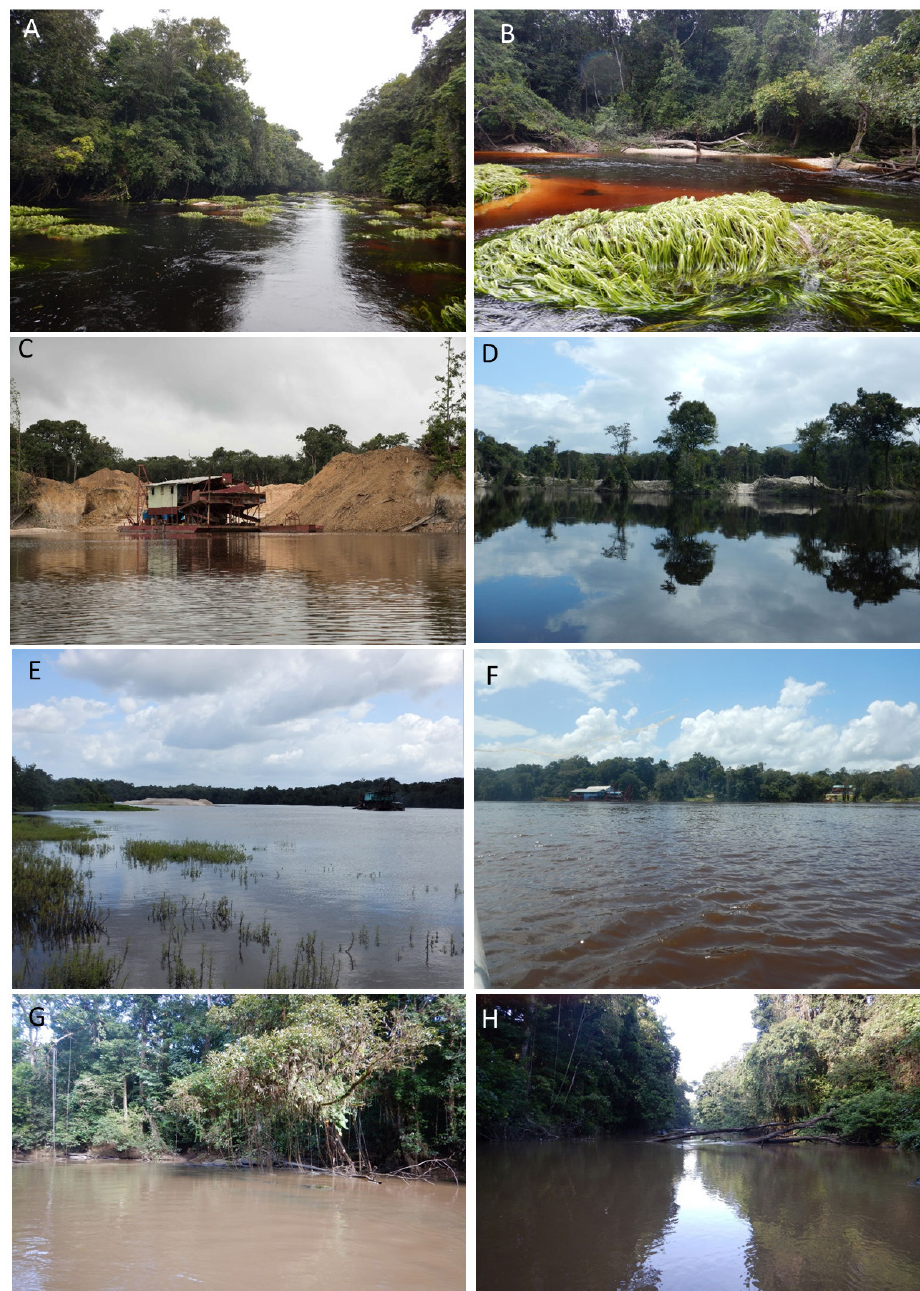
FIGURE 3 | Sampling locations on the middle Mazaruni River: A. Main channel of the upper Eping River a small, black water tributary of the Mazaruni River. This river appeared more pristine and less impacted by gold mining activities; B. Sandy, shallow habitat sampled in middle channel of the upper Eping River; C. A gold dredge in the middle of the Kurupung River, on the right side is evidence of soil removal that resulted from mining activities; D. Deforestation (to establish mining stations) along the Kurupung River upstream, left bank from the confluence with the Mazaruni River; E-F. Main channel of the Mazaruni River at Olive Creek. At this location, the main channel of Mazaruni River is highly impacted by gold mining activities and gold dredges and ‘tailing’ beaches are commonly observed; G-H . The main channel of the lower Puterang River before the confluence with the Mazaruni River. At these locations, the Puterang River carries down heavily silted sediments that are spilled into the Mazaruni